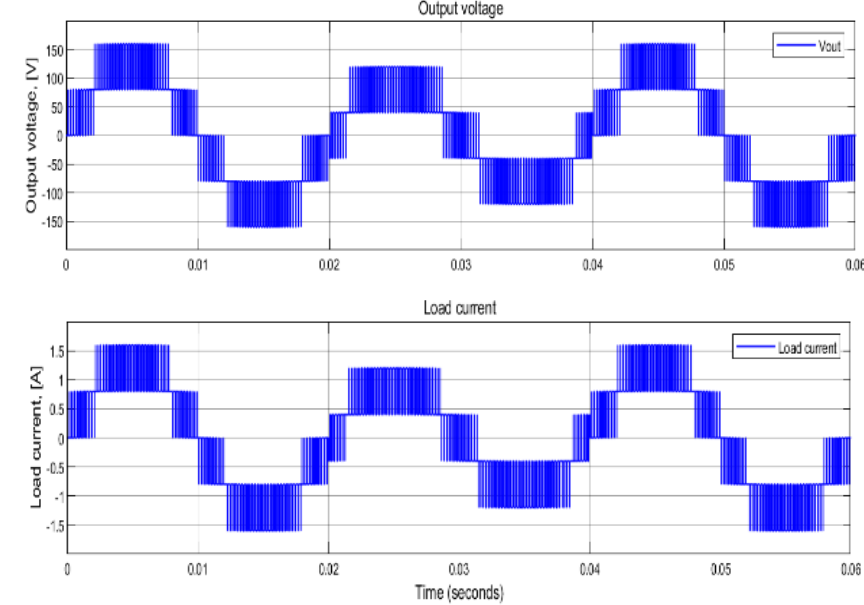
Figure 20. Output voltage waveform in a case of reconfiguration.